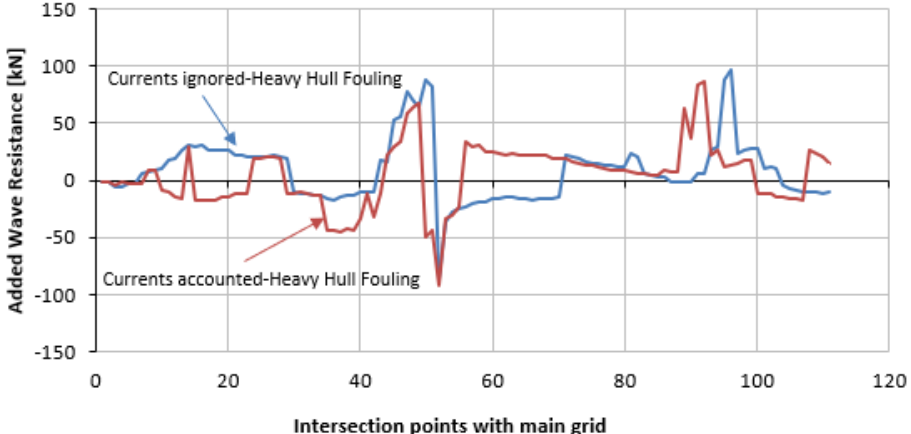
Figure 17. Added wave resistance along the optimal paths found with and without the currents’ effect under heavy hull fouling conditions.